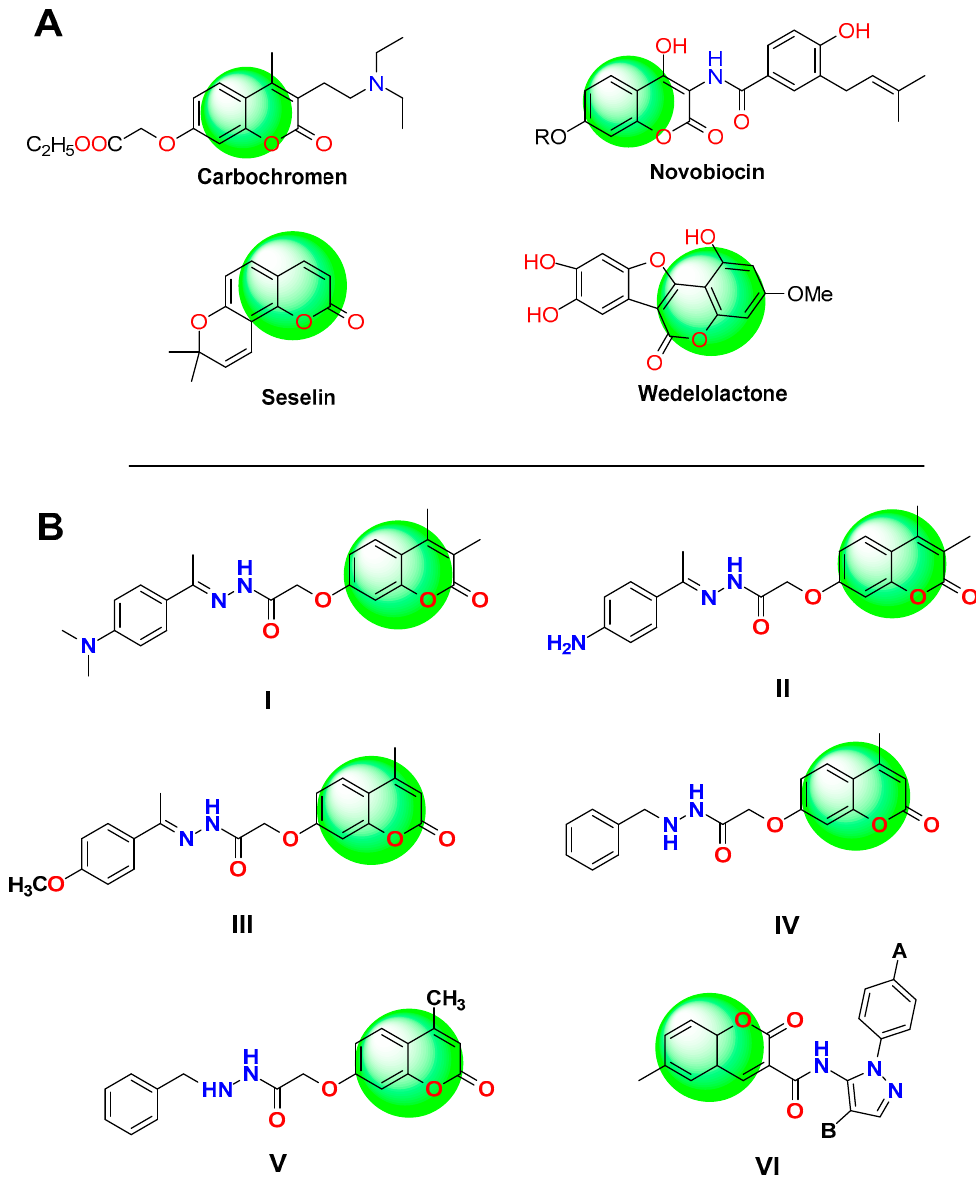
Figure 1. ( A ): Representative biological active coumarins; ( B ) structures of some of anticancer coumarin derivatives through VEGFR2 inhibition.